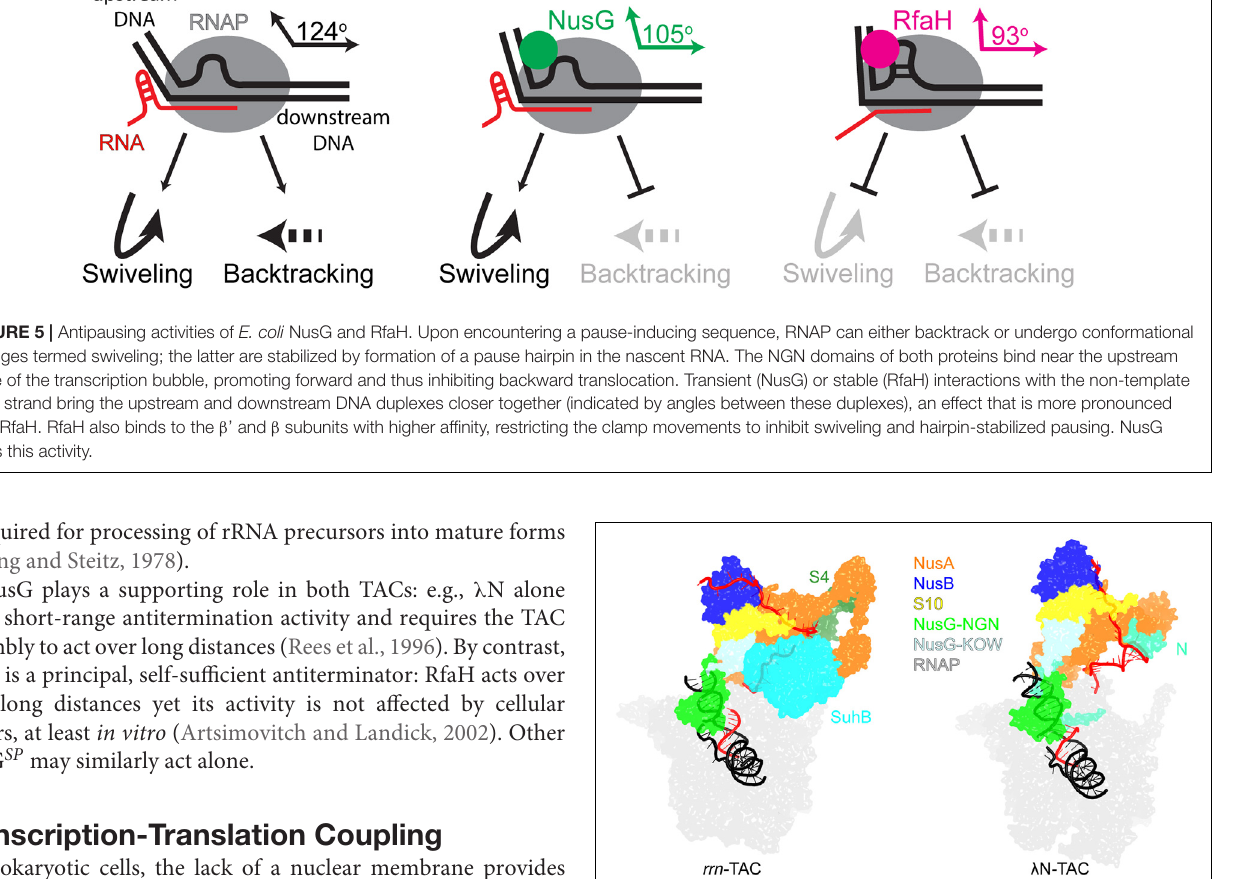
FIGURE 6 | Transcription antitermination complexes (TAC). Left, rrn -TAC; right, phage λ N-TAC. RNA is in red, DNA is in black. The unique proteins that play key roles in antitermination are shown on each complex; the shared components are indicated in the middle. PDB ID: rrn -TAC, 6TQO; λ N-TAC,